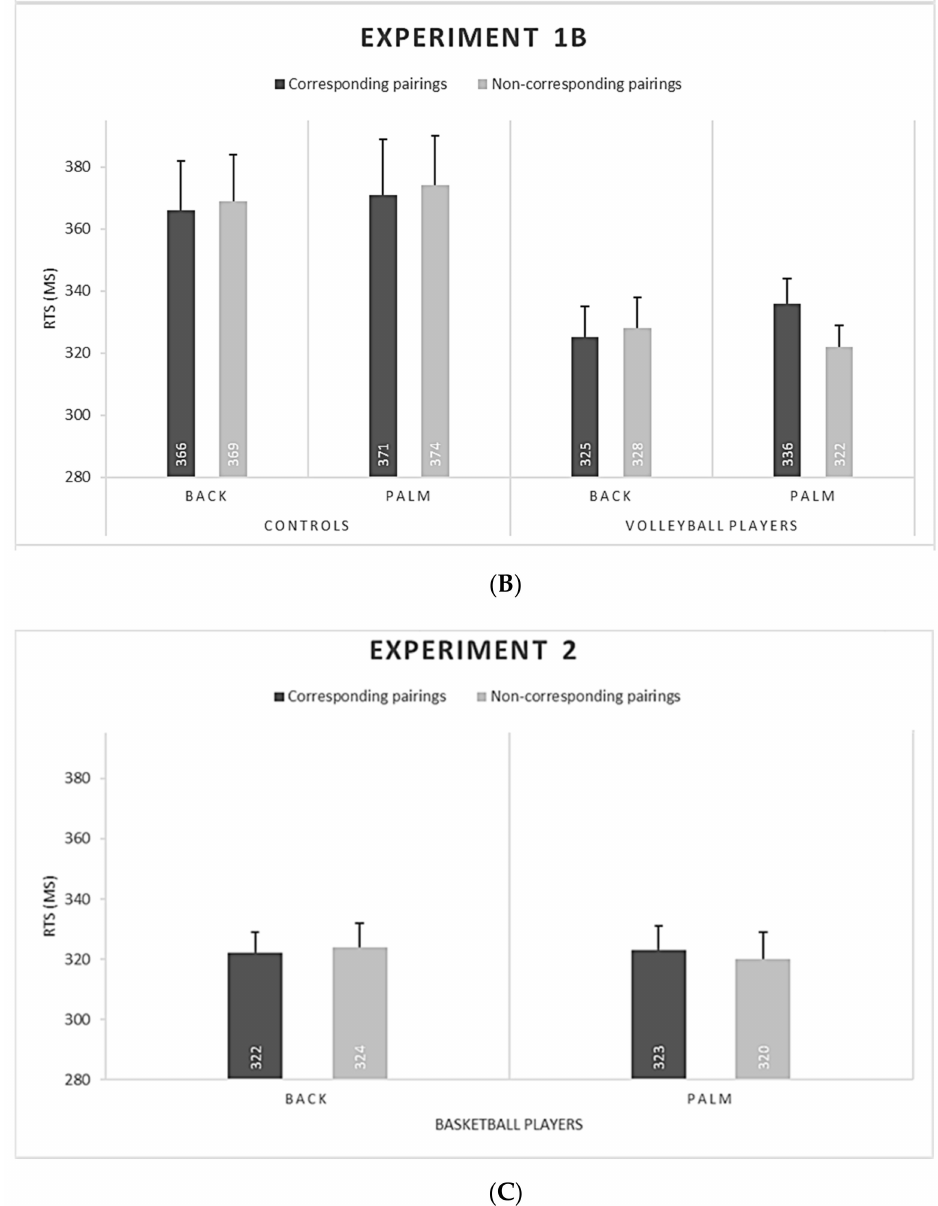
Figure 2. The graph shows RTs in Experiment 1a ( A ), Experiment 1b ( B ), and Experiment 2 ( C ), dis- played according to view (back vs. palm) and correspondence (corresponding vs. noncorresponding pairings) for volleyball players, nonathletes, and basketball